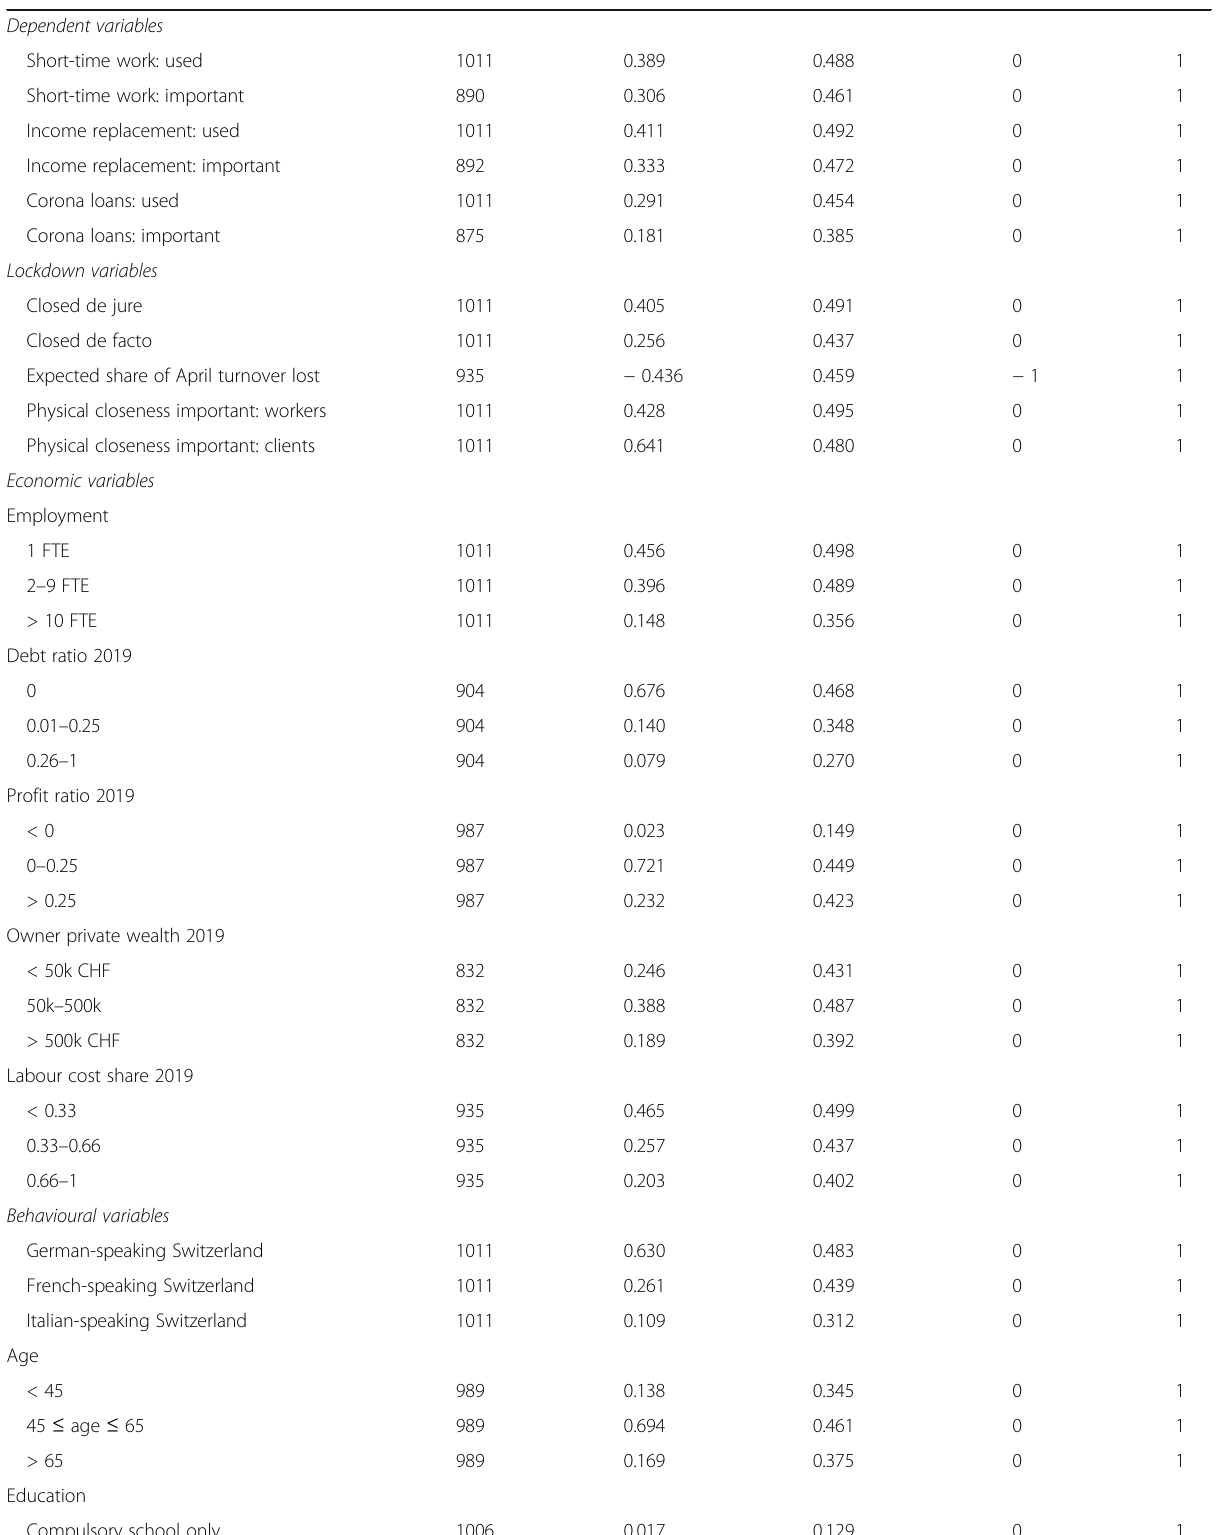
Table 1 Summary